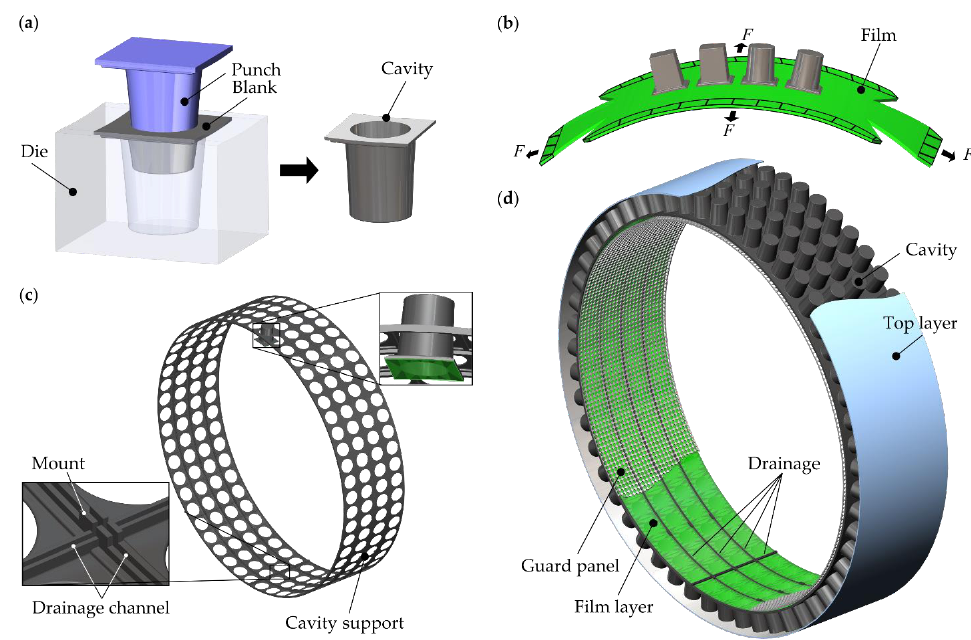
Figure 17. ( a ) Schematic thermoforming process of the resonator cavity, ( b ) joining process of the curved and pre-tensioned film and the cavity, ( c ) cavity support with functional elements such as the drainage channel and mounts for attaching the guard panel, ( d ) design concept of the barrel-shaped PR-liner.